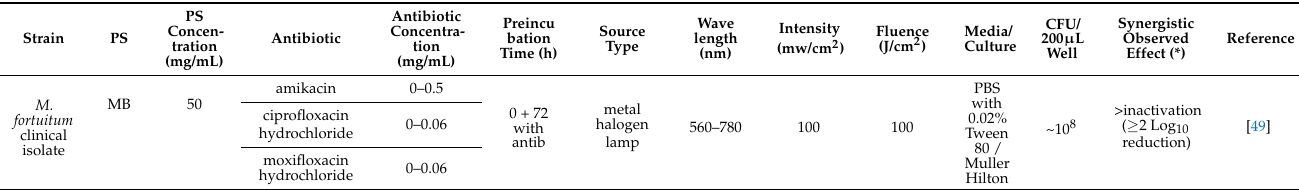
Table 3. Comparison of methodology and results of an in vitro study of aPDT followed by culture with antibiotics on Mycobacterium fortuitum .